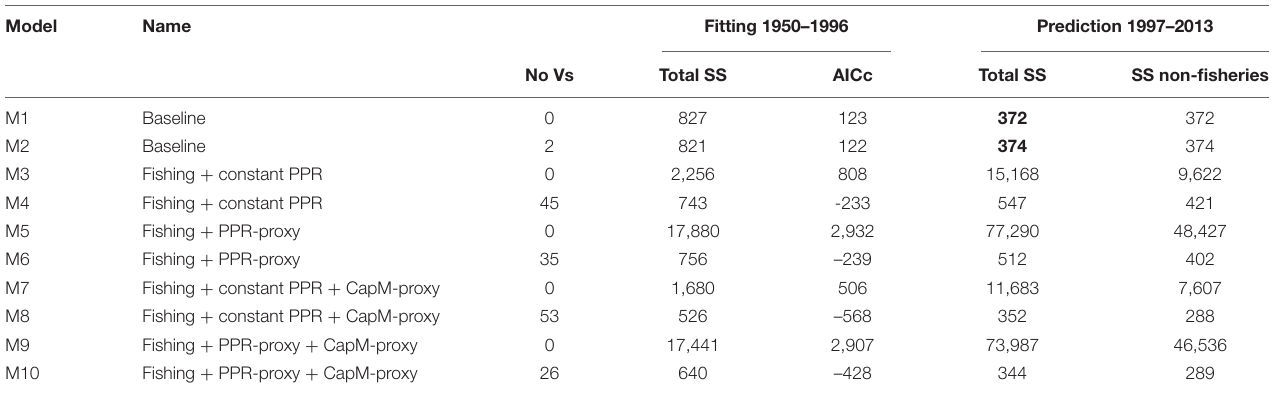
TABLE 3 | Overview of sum of squares for fit (1950–1996) and prediction (1997–2013) for alternative Ecosim